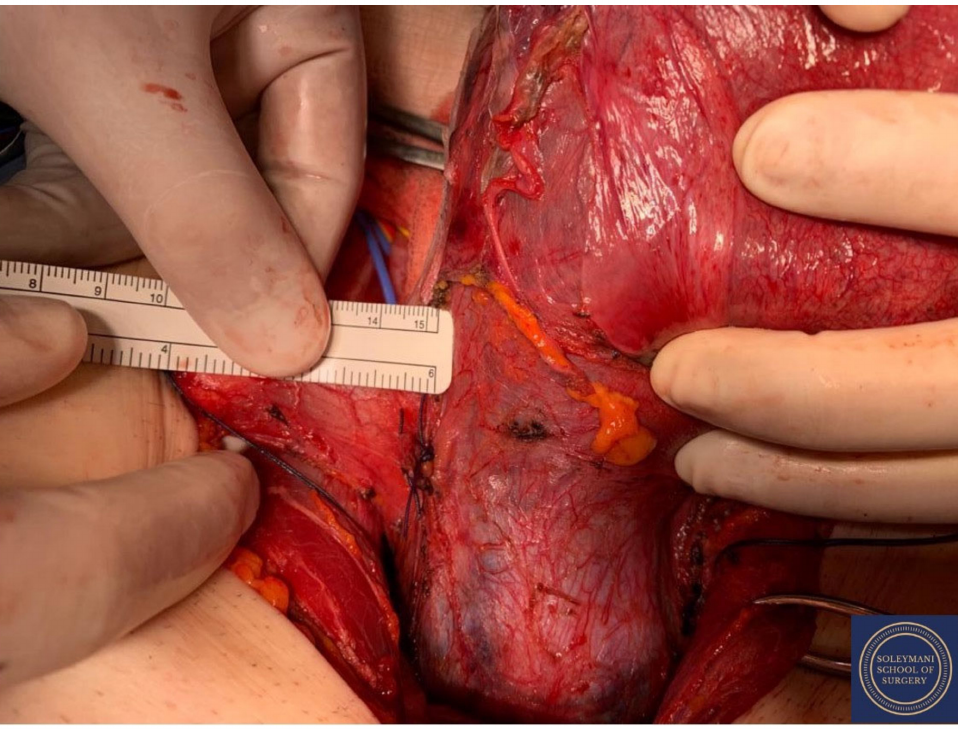
Figure 12. Complete dissection of the right parametrium.